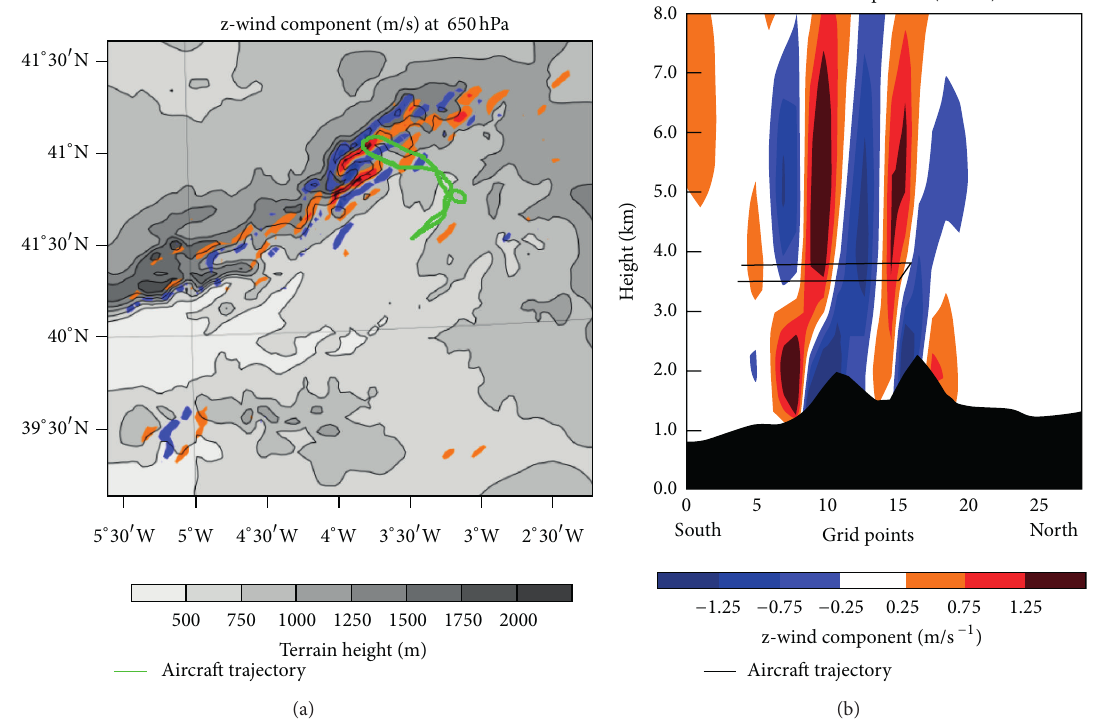
Figure 12: Vertical (z) wind component at 650 hPa (a) and on a cross section (b) of domain D03. Aircraft trajectory has been